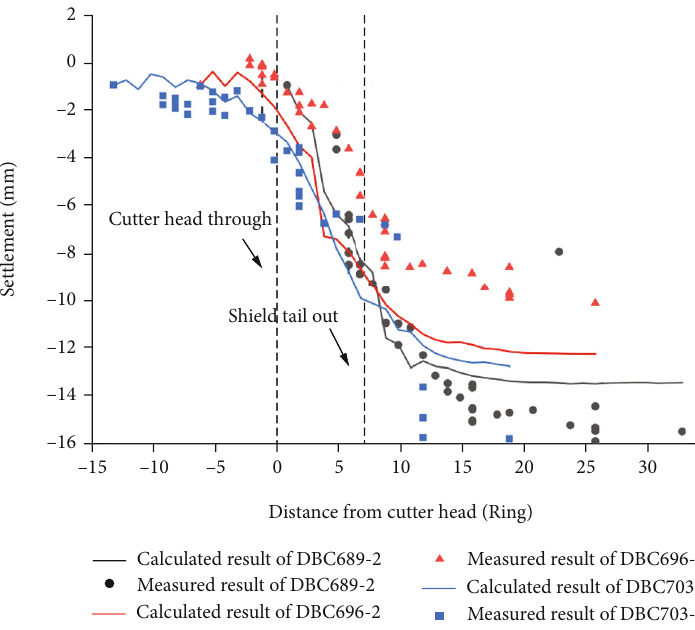
Figure 6: Comparison of settlement